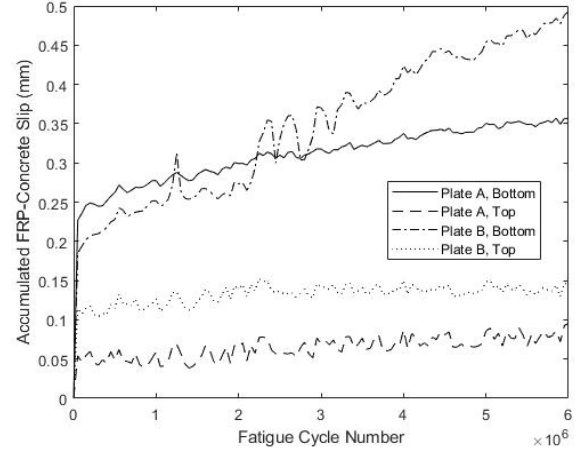
Figure 18. Fatigue-Induced Slip at FRP-Concrete Interface for S5.